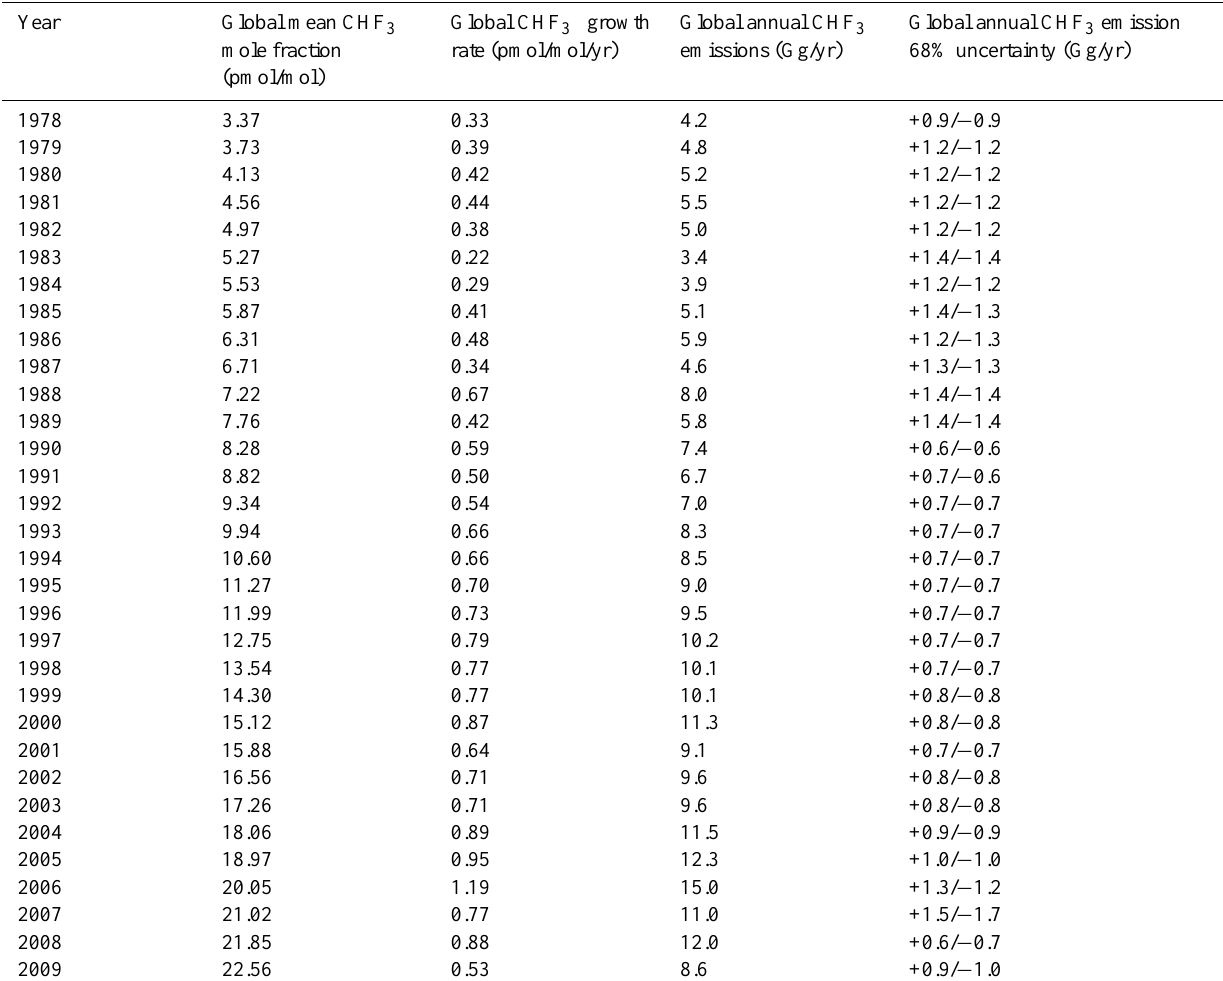
Table 3. Annual mean lower-troposphere global mean mole fractions, growth rates and emissions for HFC-23 (CHF 3 ) from 2-D 12-box model inversions of AGAGE